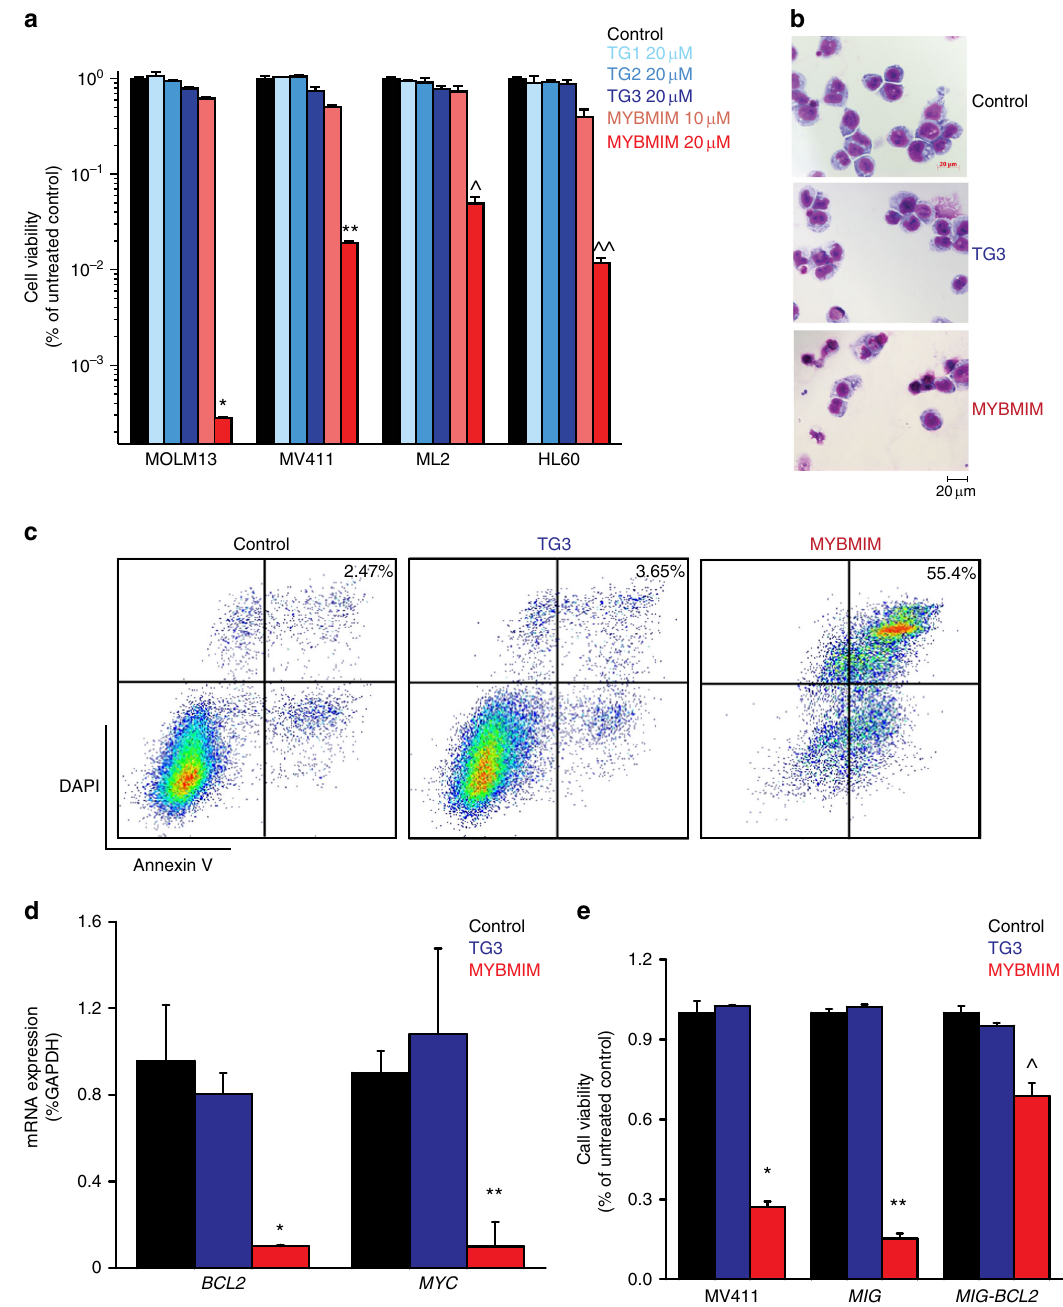
Fig. 4 MYBMIM induces apoptosis and downregulates MYB-regulated genes. a Viability of MOLM-13, MV-411, ML2, and HL60 cells, treated for 6 days with control PBS (black), 20 μ M TG1, TG2, or TG3 (blue), and 10 μ M MYBMIM (orange) and 20 μ M MYBMIM (red), with peptide replacement every 48 h. Error bars represent standard deviations of three biological replicates. * p = 7.2e – 7; ** p = 9e – 6; ^ p = 1.7e – 6; ^^ p = 3.3e – 6 when compared to untreated control. b Representative photographs of Giemsa-stained MV-411 cells after 6 h treatment, as indicated. Scale bar corresponds to 20 μ m. c Flow cytometry analysis of apoptosis of MV-411 cells upon peptide treatment at 20 μ M for 24 h, as indicated. Numbers denote percentage of cells that are both Annexin V and DAPI positive. d Analysis of BCL2 and MYC mRNA expression in MV411 cells as measured by qRT-PCR, upon treatment with control PBS (black), 20 μ M TG3 (blue), and 20 μ M MYBMIM (red) for 6 h. Error bars represent standard deviations of three biological replicates. * p = 0.0046; ** p = 0.008 when compared to untreated control. e MV-411 cells expressing MSCV-IRES-GFP (MIG) BCL2 but not empty MIG or wild-type cells are protected from treatment with 20 μ M MYBMIM (red) as compared to control PBS (black) and 20 μ M TG3 (blue) peptides. Error bars represent standard deviations of three biological replicates. * p = 1.4e – 5; ** p = 4.2e – 7; ^ p = 0.0005 MYBMIM treatment compared to respective untreated